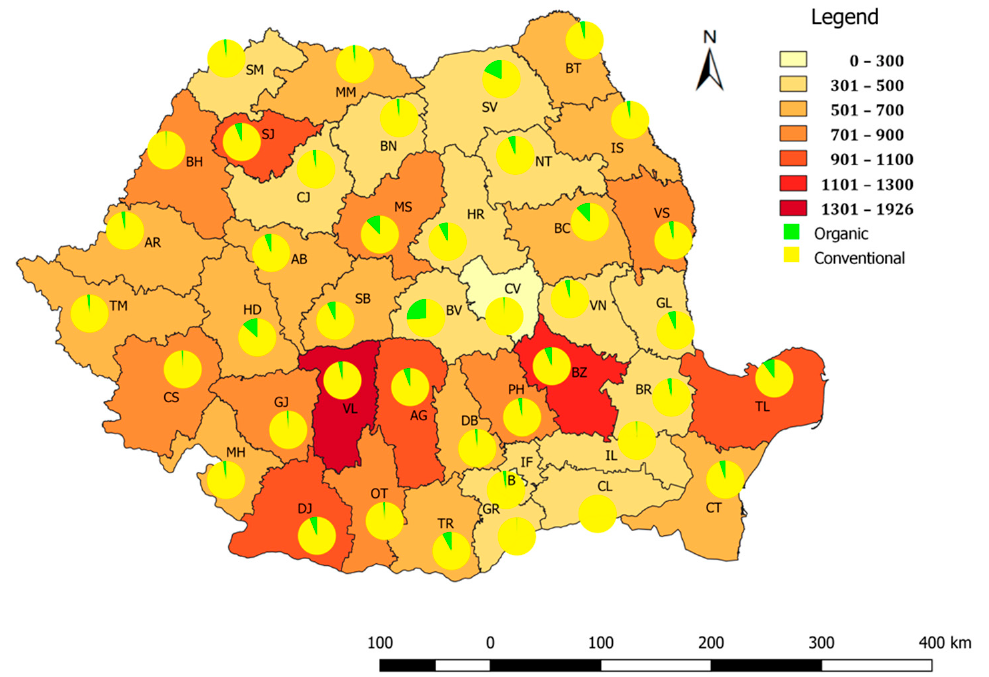
Figure 2. The distribution of apiaries in Romania (2019) .